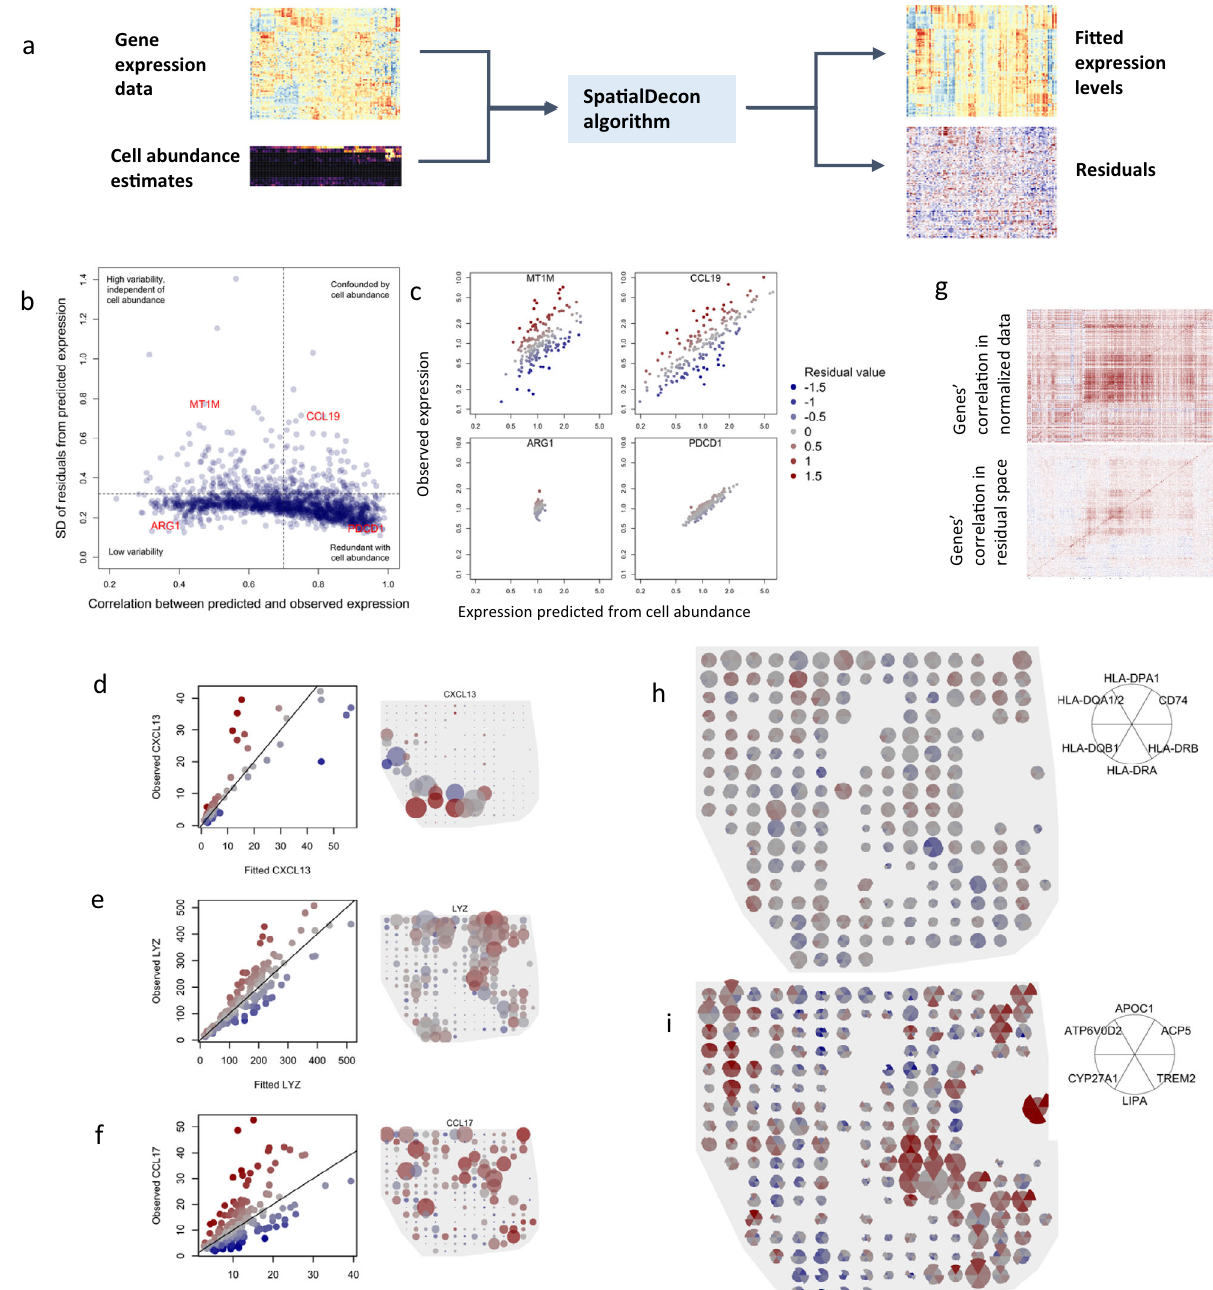
Fig. 6 Results of reverse deconvolution in a NSLCL tumor. a Schematic of reverse deconvolution approach: gene expression is predicted from cell abundance estimates using the SpatialDecon algorithm, obtained fi tted values and residuals. b Genes ’ dependence on cell mixing. The horizontal axis shows Pearson correlation between observed expression and fi tted expression based on cell abundance. Vertical axis shows the standard deviation of the log2-scale residuals from the reverse deconvolution fi t. c Example genes from the extremes of the space of panel ( b ) are shown, with observed expression (vertical axis) plotted against fi tted expression (horizontal axis). Color scale applies to panels c , d , e , f , h , i . d – f For CXCL13, LYZ and CCL17, observed expression is plotted against fi tted expression (left), and observed expression is plotted in the space of the tissue (right). In all panels, point color indicates residuals. In panels on the right, point size is proportional to observed expression level. g Pearson correlation matrices of genes in log-scale normalized data (top) and in residual space (below). h , i Spatial expression of gene clusters de fi ned by high correlation in residuals of reverse deconvolution. Wedge color shows genes ’ residual values; wedge size is proportional to genes ’ expression levels. Source data are provided as a Source Data fi such closely-related cell types, we created a second, more granular To con fi rm the stability of SpatialDecon when using granular cell pro fi le matrix. Using the same genes as the SafeTME, we cell pro fi le matrices, we re-ran the benchmarking analysis of merged pro fi les from 42 immune cell sub-clusters de fi ned in a Fig. 4a with this expanded matrix. We then compared marker scRNA-seq study 17 with the fl ow-sorted fi broblast and endothe- protein expression with the total abundance of relevant cell types, lial cell pro fi les 18 . for example comparing CD68 protein to the total abundance